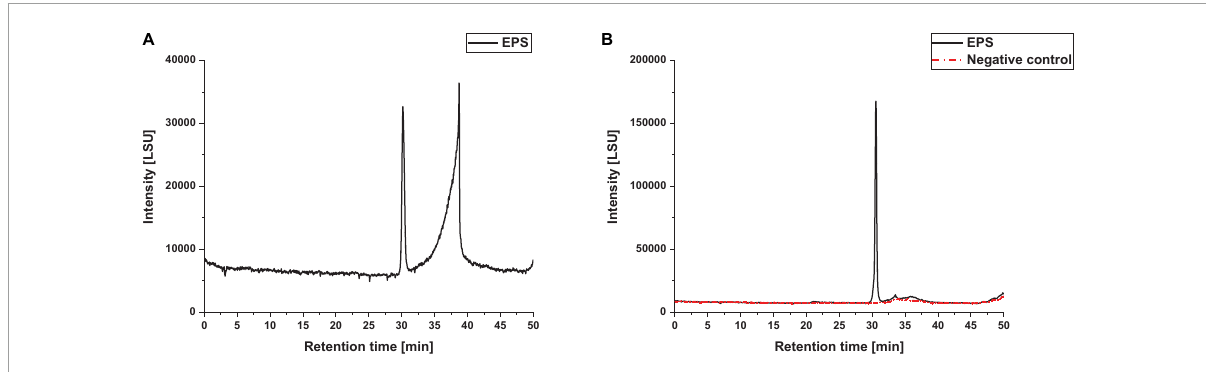
FIGURE5 SEC-ELSD size distribution profiles of EPS fractions from S. acidocaldarius MW001 biofilms. (A) Non-treated EPS extract and (B) enzymatically treated EPS extract and corresponding negative control sample are shown. Both EPS sample and negative control were subjected to RNaseA, DNaseI, and proteinase K treatment for the removal of macromolecular